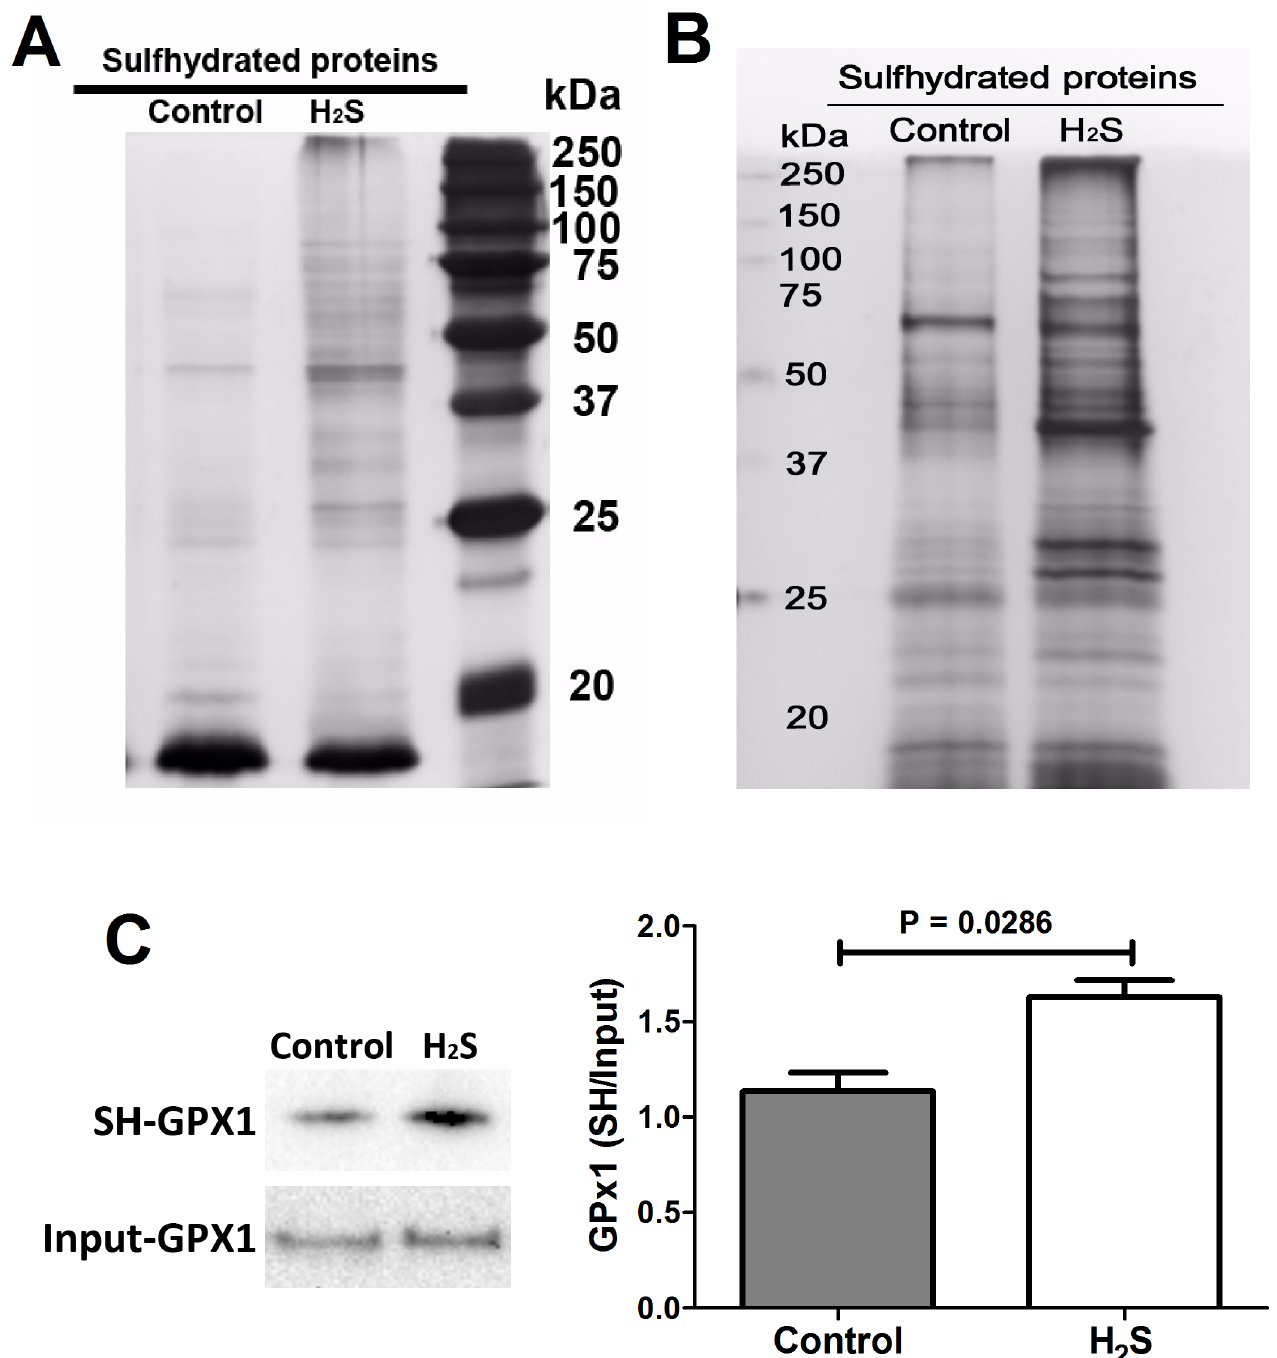
Fig 5. H 2 S effects on S -sulfhydrated proteins and GPx1 S -sulfhydration. (A) Gel staining of biotinylated proteins in control and H 2 S-treated ApoE KO mice. (B) Detection of S -sulfhydrated proteins by western blot analysis in control and H 2 S-treated ApoE KO mice. There was an increase of S -sulfhydration upon H 2 S treatment. (C) Representative blot image of immunoprecipitated GPx1 from control and H 2 S-treated mice aorta was extracted from the blot of first mice pair (control and